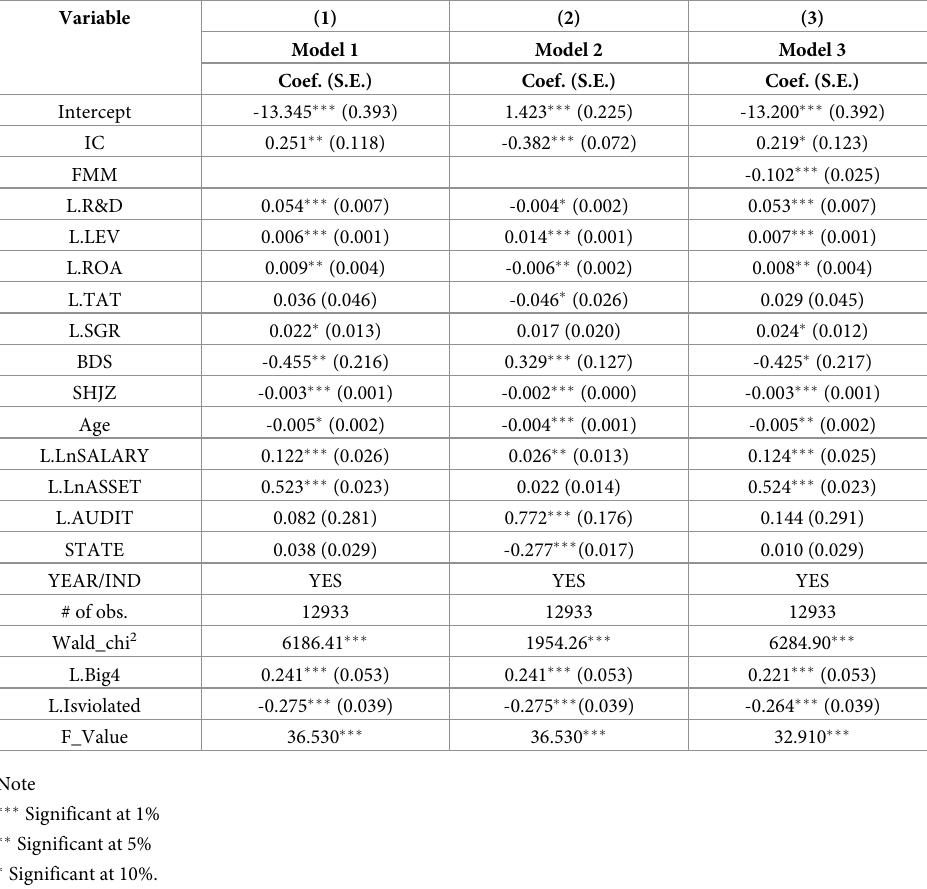
Table 6. Test results for instrumental variable